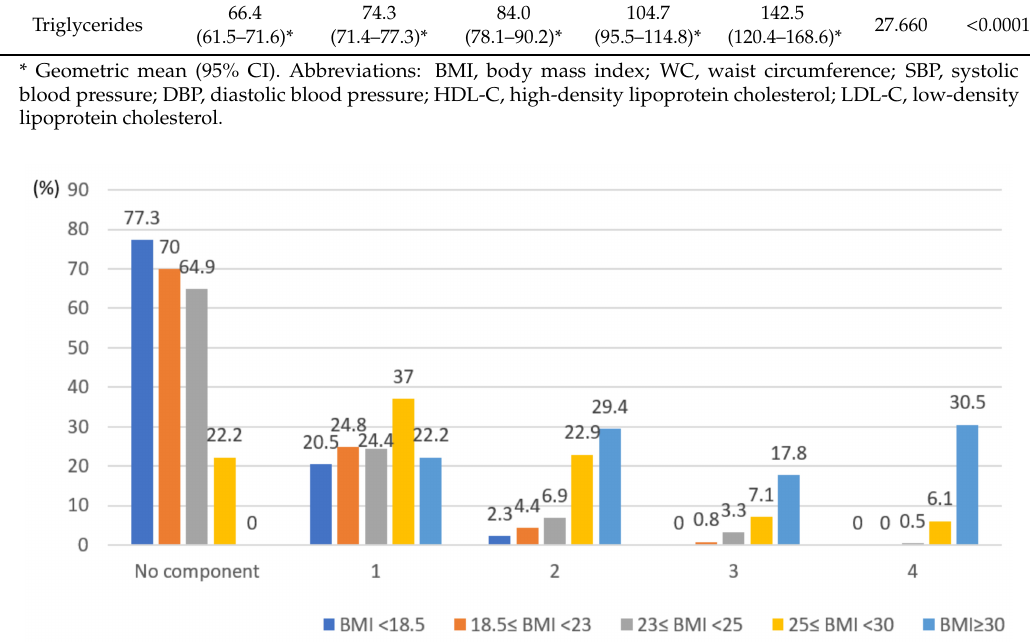
Figure 3. Association between the number of metabolic syndrome components and body mass index (n = 1310). Metabolic syndrome components: waist circumference, blood pressure, fasting glucose, triglycerides, and high-density lipoprotein